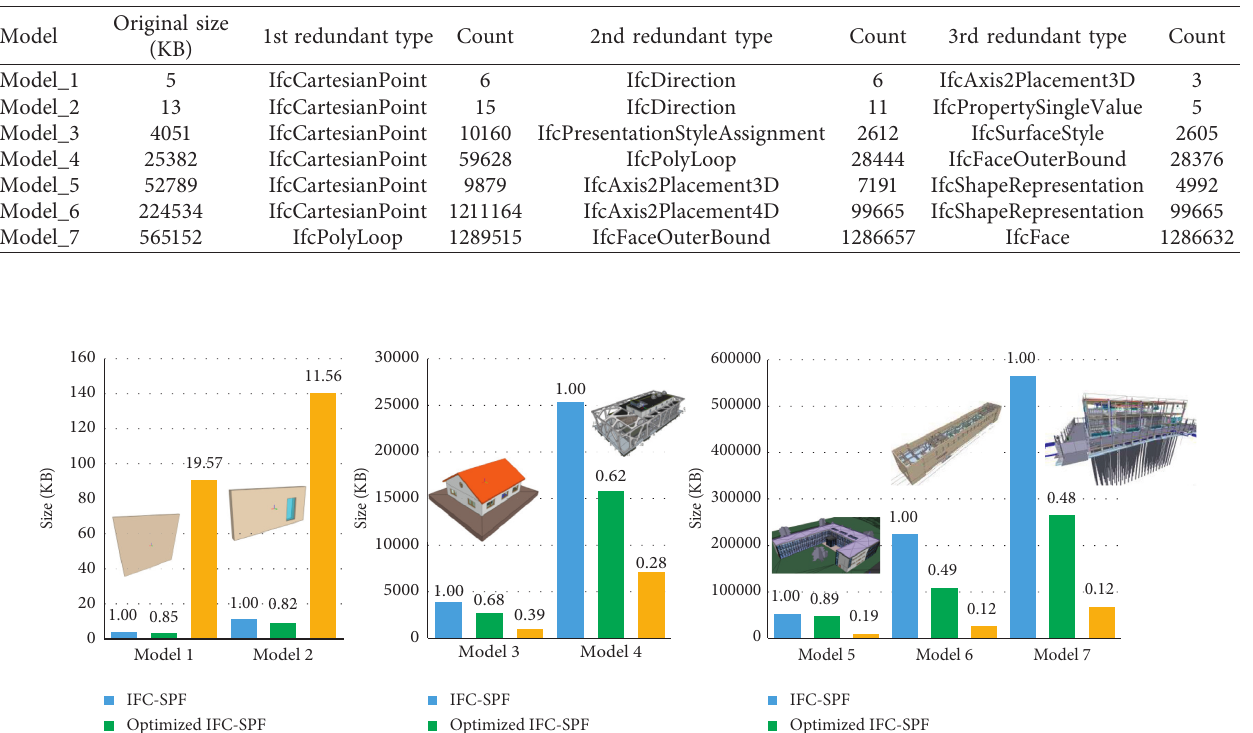
Figure 20: Comparison between original (left) and optimized (right) checked in BIMVision (a free viewer for IFC) (pcs means the count of components here). Table 1: Partial duplicate count for 7 test IFC-SPFs.